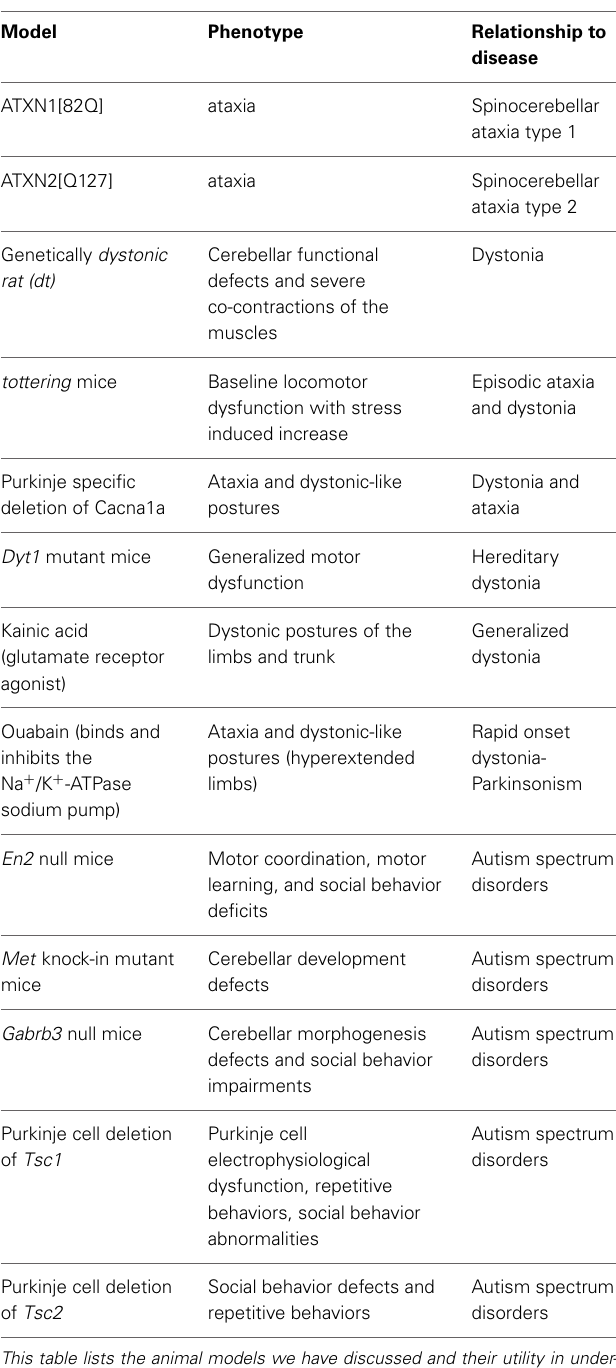
Table 3 | Animal models of cerebellar